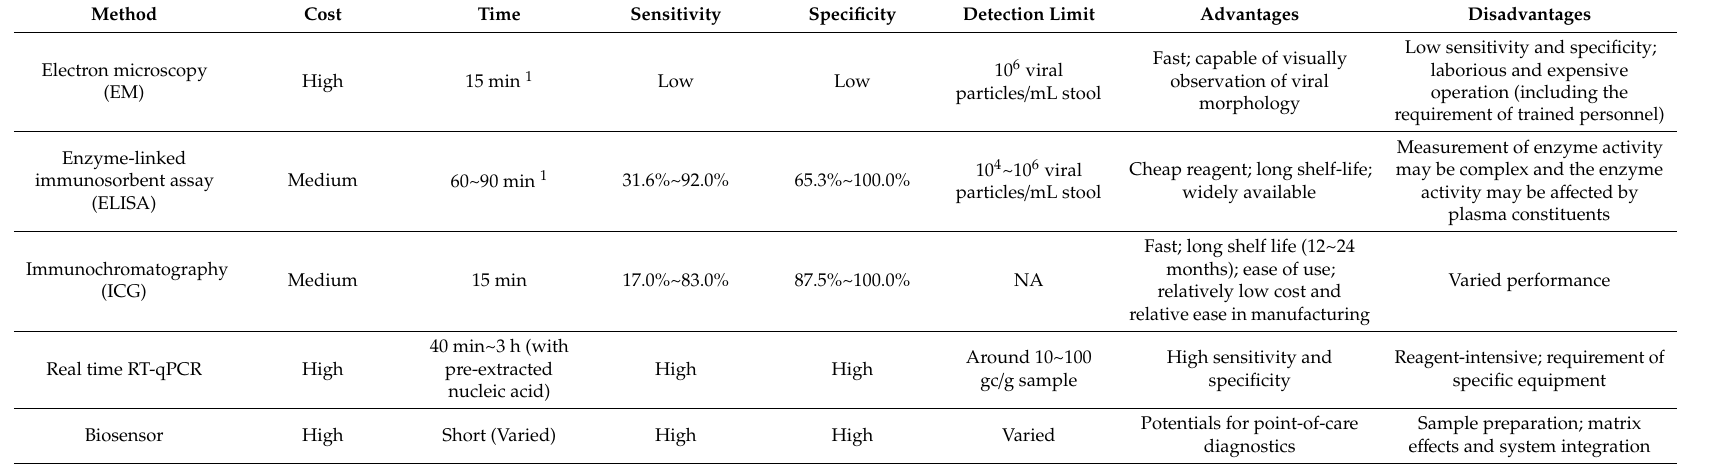
Table 1. Comparison of di ff erent types of methods for human norovirus (HuNoV)